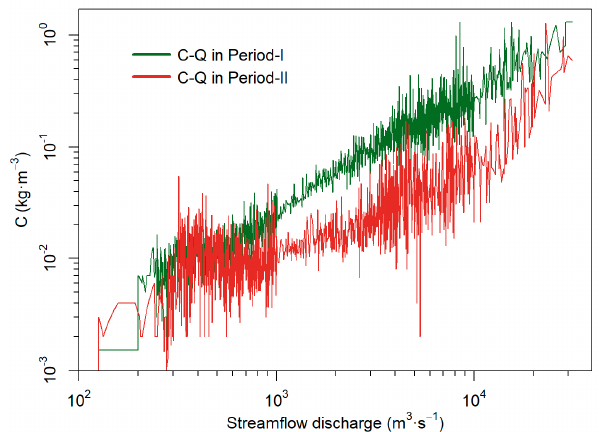
Figure 7. The sediment rating curves between suspended sediment concentration ( C ) and